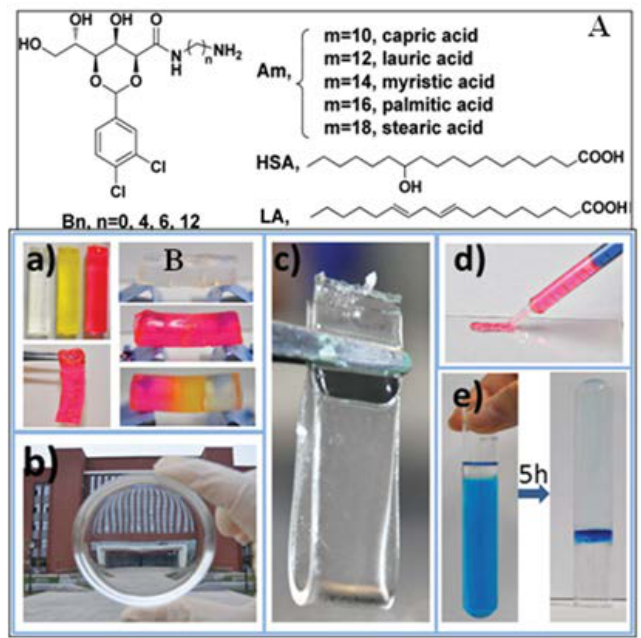
Figure 34. ( A ) Structure of Bn and aliphatic acids; ( B ) (a) Illustration of self-healing properties of the CB gels (2.0% w / v ) obtained from undoped B6–A10 gel, yellow dye-doped B6–A14 gel, and red dye-doped B6–A18 gel. (b) View of the building from a distance of 50 m through B6–A18/CB gel. (c) B6–A18/CB gel film. (d) Extrusion of red dye-doped B6–A18/CB gel from a syringe. (e) 20 mg B6–A18 powders were added to the mixture of 1 mL benzene and 10 mL of 0.1 mM aqueous solution of methylene blue. Reprinted with permission from [137]. Copyright 2016 Royal Society of Chemistry.